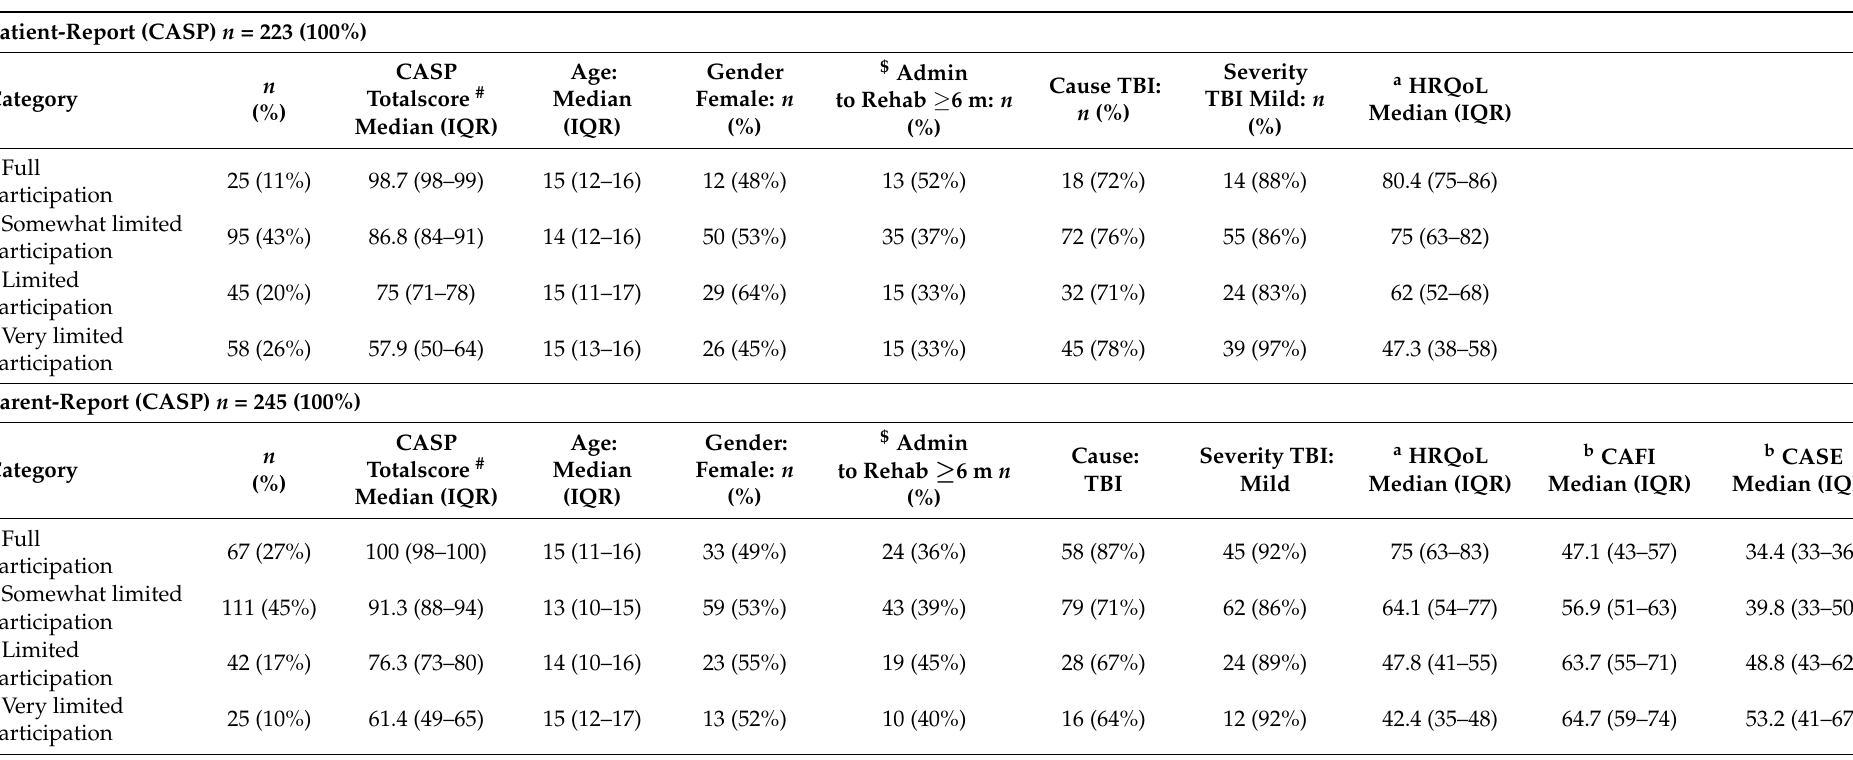
Table 3. Within group characteristics of children and young adults with acquired brain injury (ABI) based on CASP participation restriction categorization. Patient-Report (CASP) n = 223